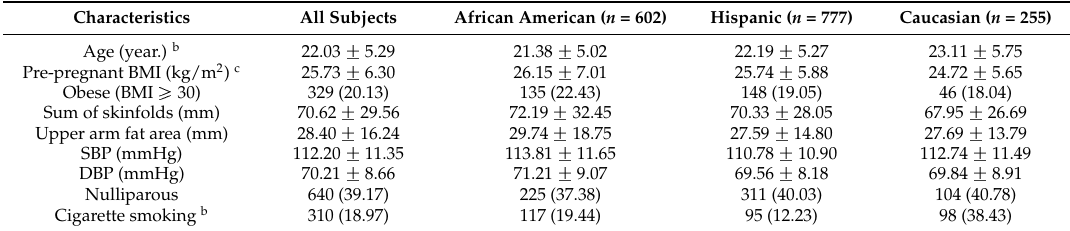
Table 1. Characteristics of study participants at entry by ethnicity a .